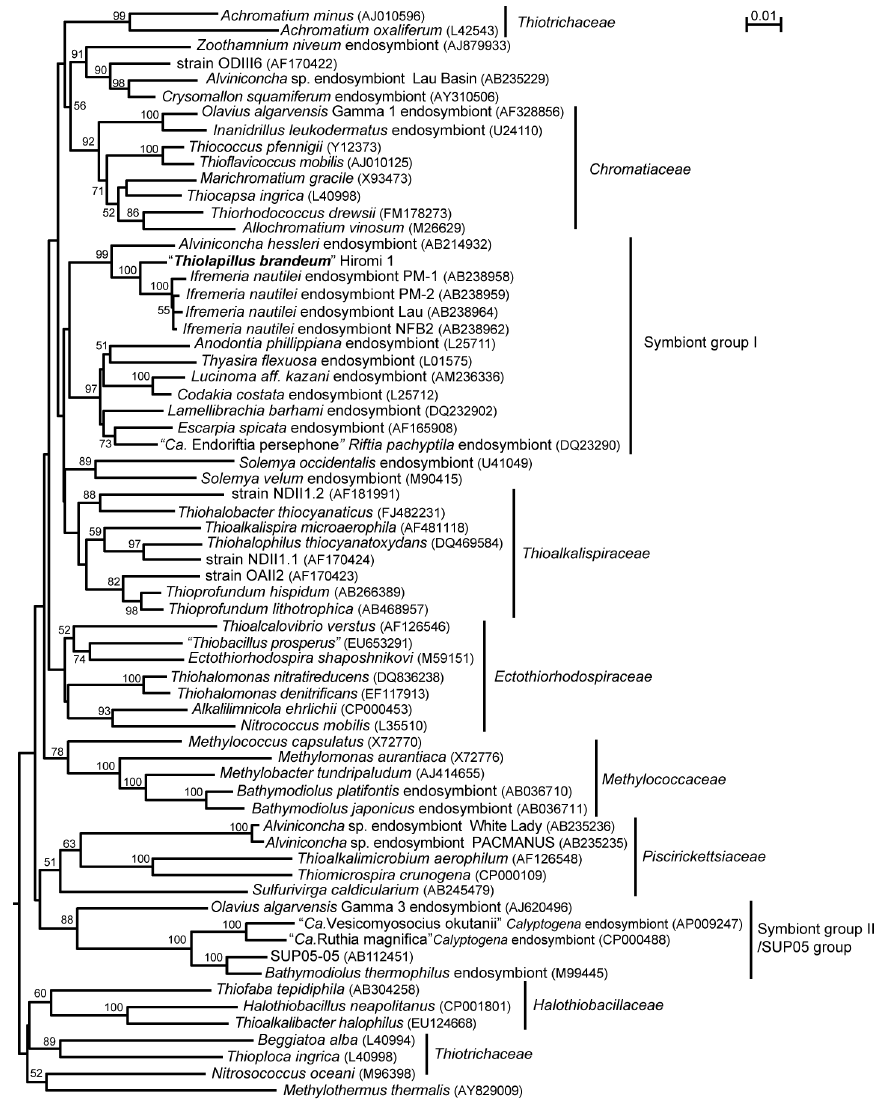
Figure 2. A SSU rRNA gene phylogenetic tree of chemolithoautotrophic and methanotrophic Gammaproteobacteria including strain Hiromi 1 constructed by the neighbor-joining method using 1253 identical positions. Bootstrap values higher than 50% are presented. GenBank/EMBL/DDBJ accession numbers are given in parentheses. Bar indicates 1 substitutions per 100 nucleotides.